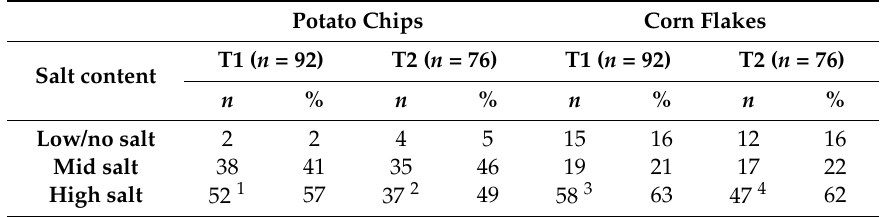
Table 4. Children’s identification of the most salty chip and cornflake sample at time points 1 and